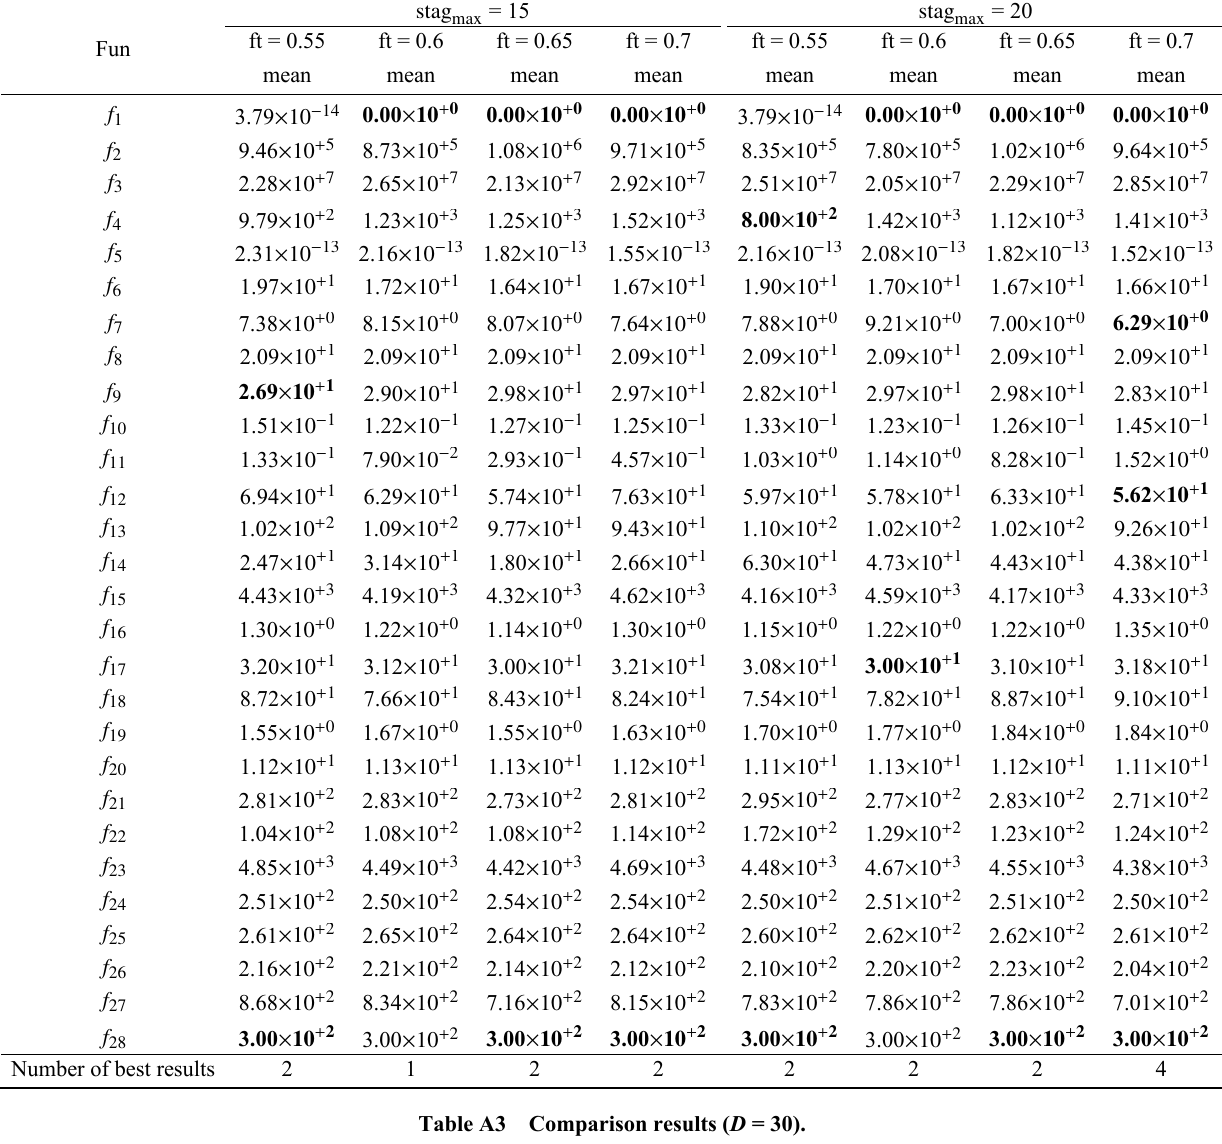
(stag =15, 20) investigation of DHLPSO. max max